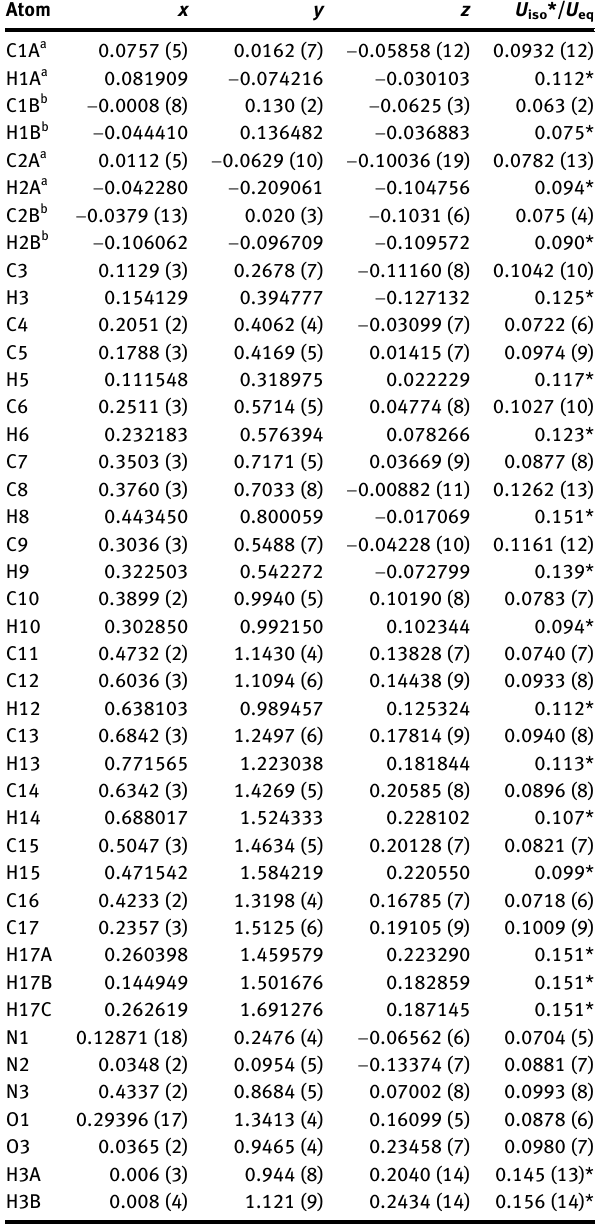
Table  : Fractional atomic coordinates and isotropic or equivalent isotropic displacement parameters (Å 